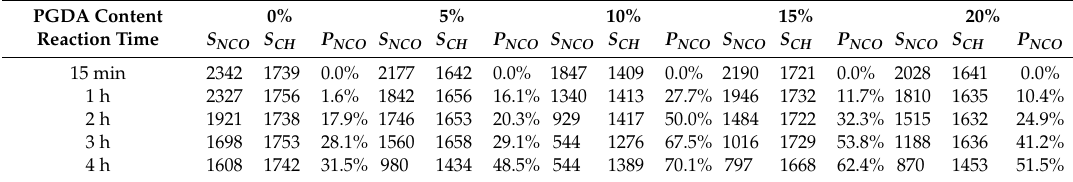
Table 5. Characteristic peak areas and reaction degrees of NCO.